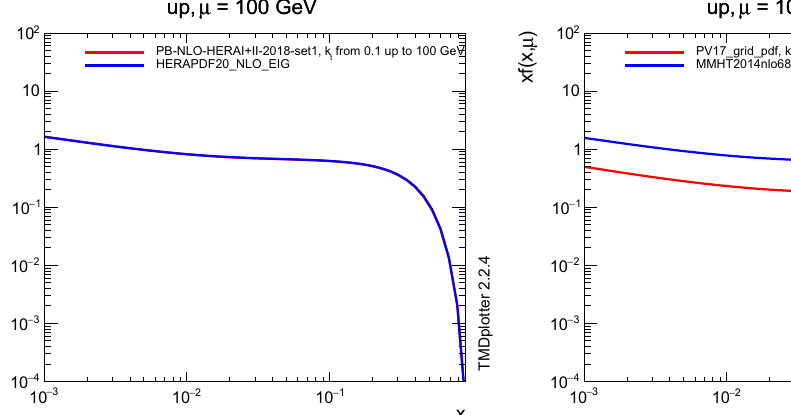
Fig. 1 Comparison of up-type parton distributions, x f ( x ,μ) = x A int ( x ,μ) asafunctionof x at μ = 100 GeV(left):comparisonofthe integrated distribution PB-NLO-HERAI+II-2018-set1 [45] with HER-